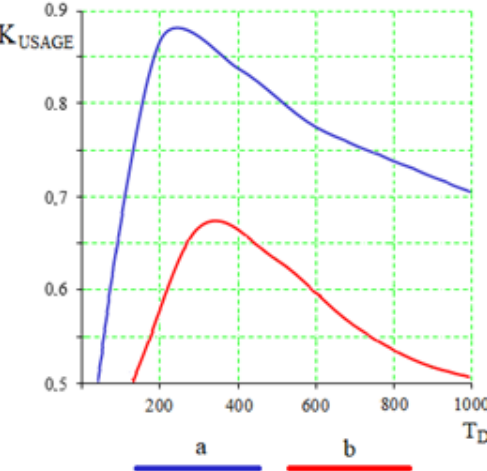
Figure 2. Dependences of the coefficients of technical use (Kusage) to determine the optimal diagnostic period for torpedo ladle cars: a—dependence of the technical utilization factor on the period of the PM350t diagnostic torpedo ladle cars for the modified version (with Sd); b—dependence of the technical utilization factor on the period of the PM350t diagnostic torpedo ladle cars for the basic version (without Sd).